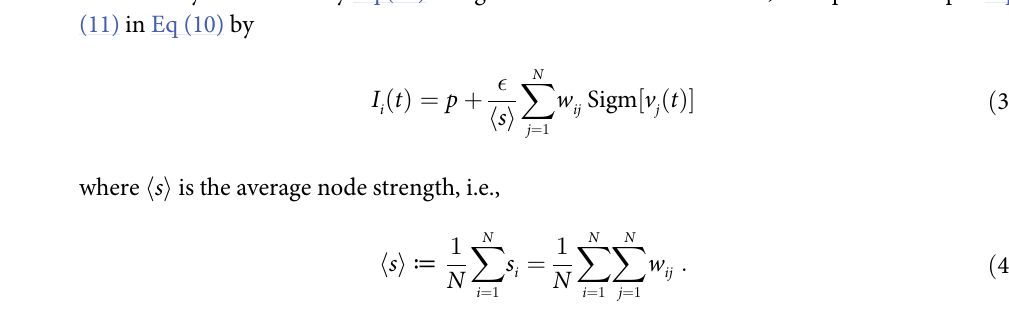
. (g) Correlation between the phase difference ϕ C i i −